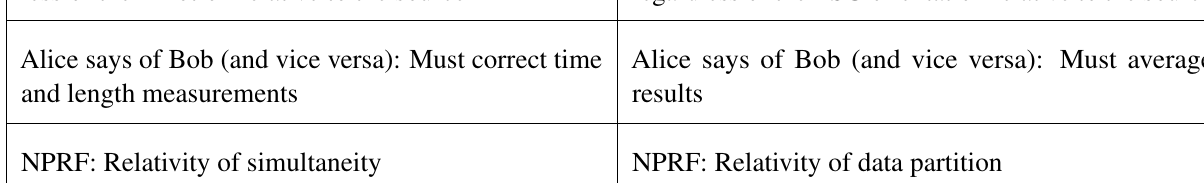
(cid:16) ℏ (cid:17) , regardless of their SG magnet orientation 2